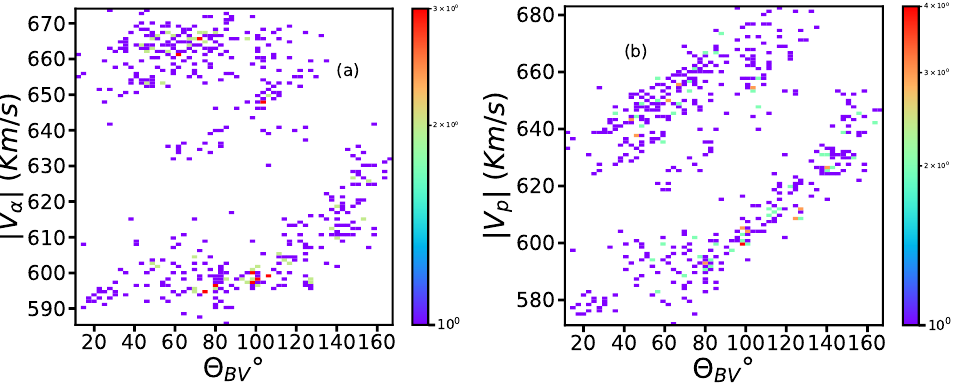
Figure 3. 2D histogram plot of ( a ) alpha bulk speed ( | V α | ) and ( b ) proton bulk speed ( | V p | ) vs. θ BV of the fast wind interval observed by WIND at 1 au on 15 March 2007. The color bar represents the number of